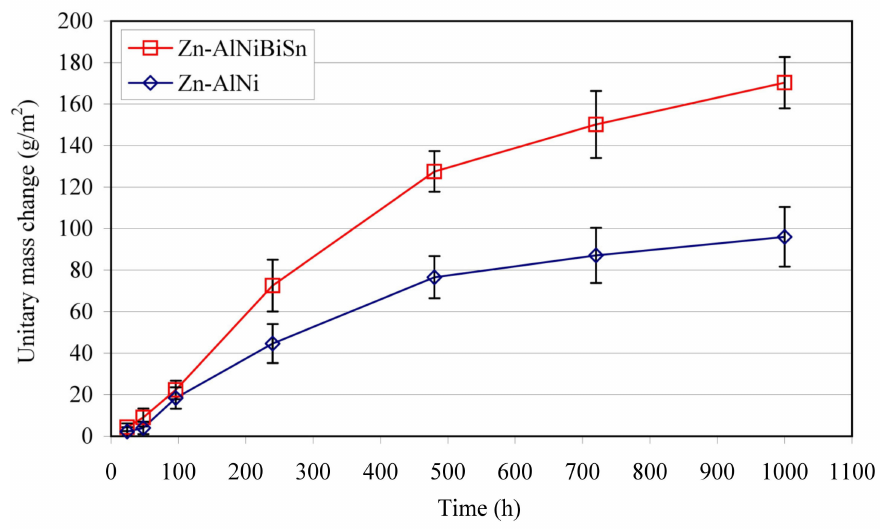
Figure 7. Unitary mass change of Zn-AlNiBiSn and Zn-AlNi coatings as determined from the neutral salt spray